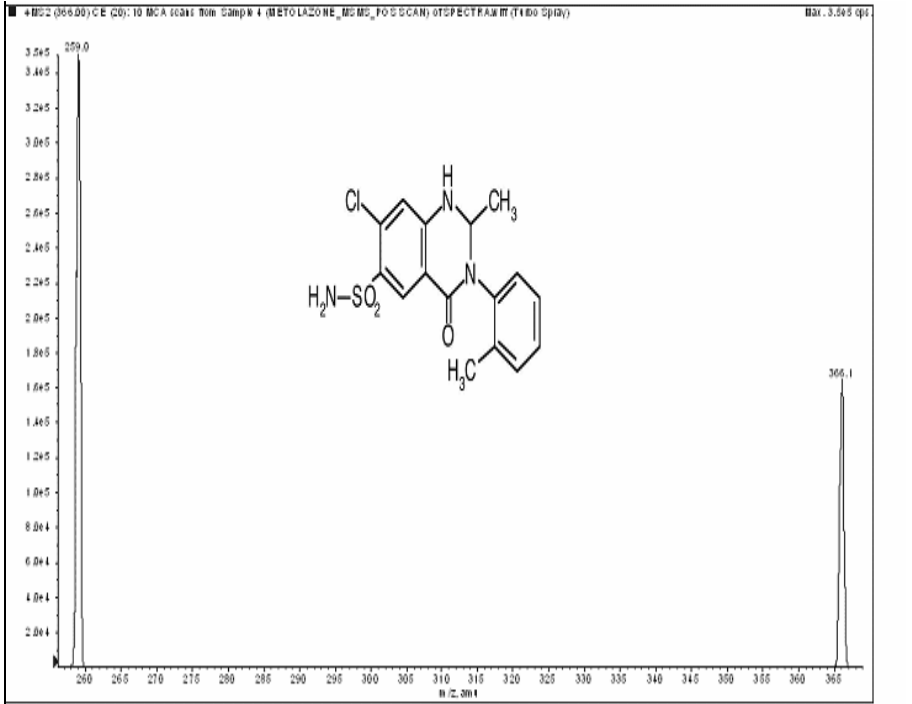
Figure 1. Metolazone MS-MS scan (366.1>